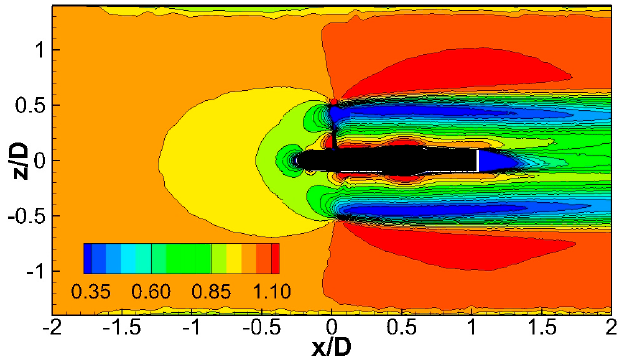
Figure 4. Contour of velocity in the region upstream of the rotor is shown in the y = 0 plane using OpenFOAM URANS results.